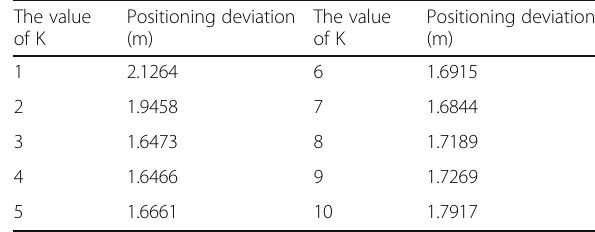
Table 2 The influence of the value of k on the